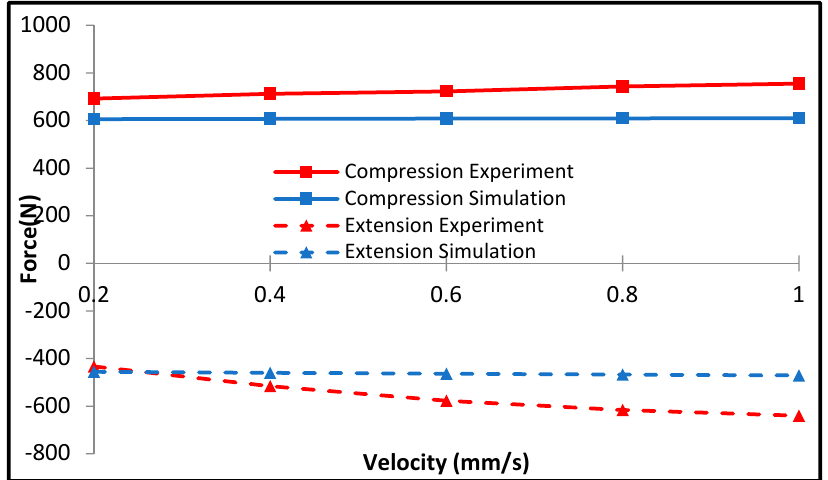
Figure 19. Damping force comparison at 0.3 A between simulation and experiment.